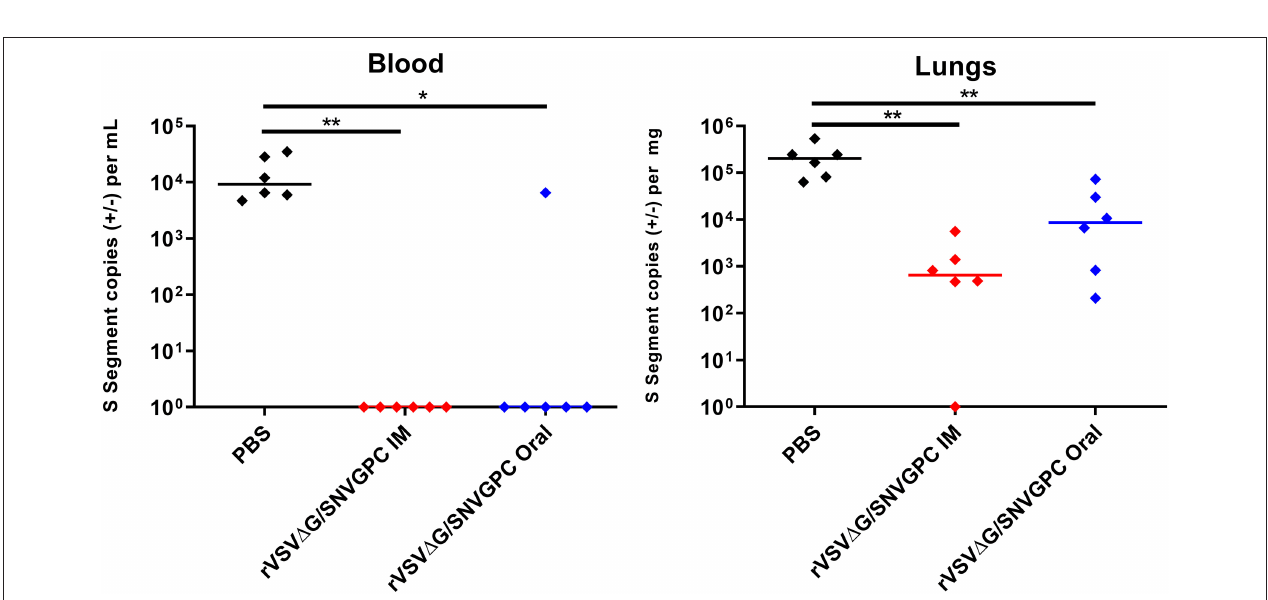
FIGURE 1 | Humoral immune responses in deer mice vaccinated with rVSV 1 G/SNVGPC. Deer mice were vaccinated with 2 × 10 4 PFU of rVSV 1 G/SNVGPC either IM or via oral gavage. After 28 days, sera were collected from vaccinated mice and the presence of (A) total anti-SNV IgG was detected, or (B) anti-SNV neutralizing antibodies were detected. Shown are data means + standard deviation n = 36. Data shown are combined from two separate experiments. Statistical significance assessed by Mann-Whitney test **** p < 0.0001.